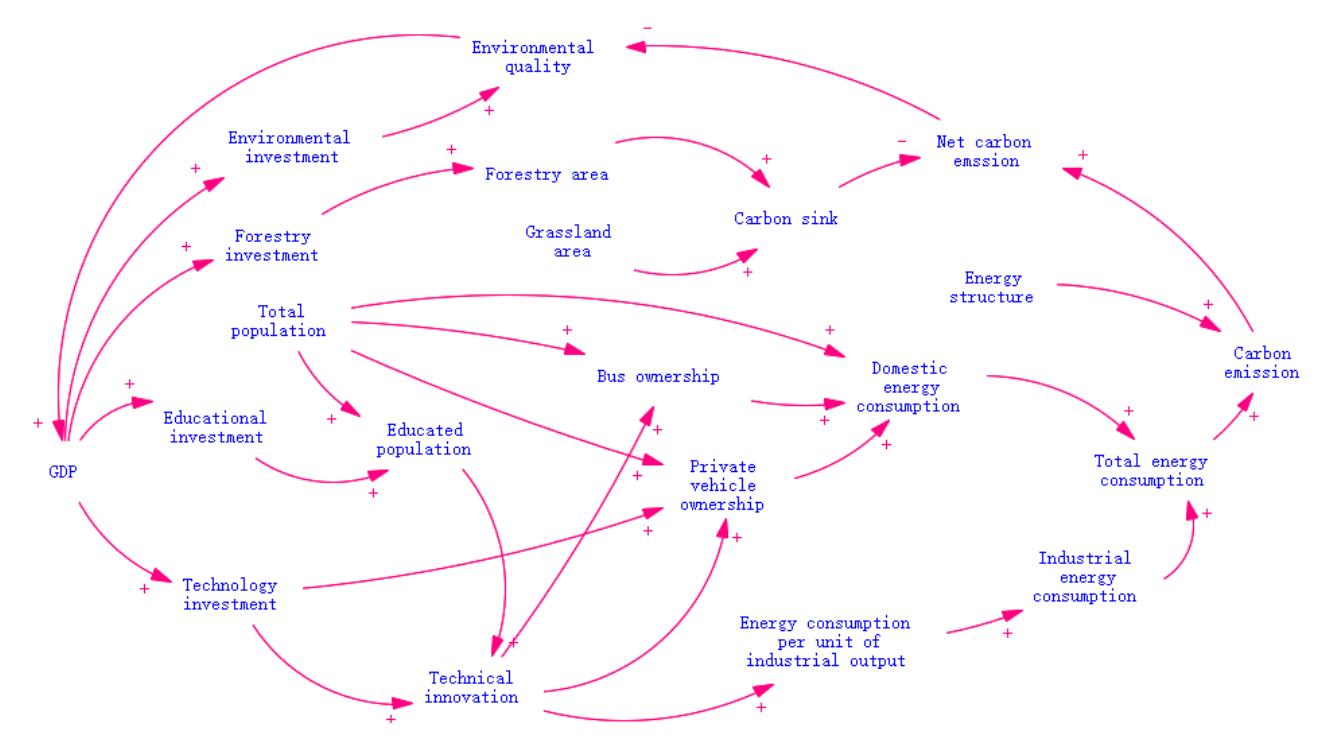
Figure 3. Carbon dioxide emission causation.